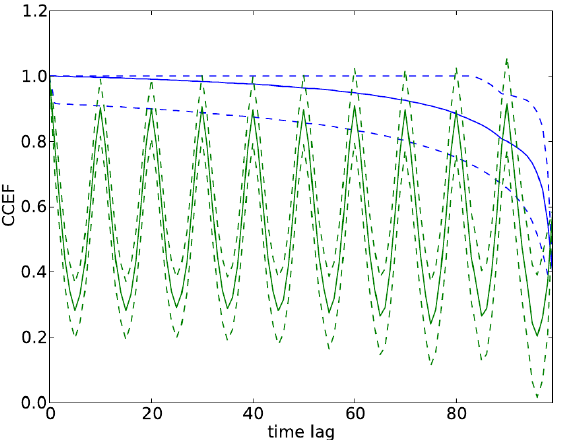
Fig. 3: CCEF for networks from the START model with peri- odic (green) and linearly increasing (blue) forcing parameter F. The error bars indicate the standard deviation of the CC size estimates.